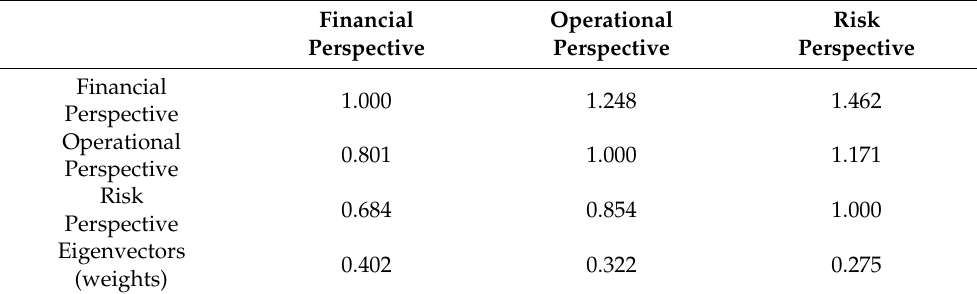
Table 2. The comparisons and eigenvectors (weights) of 3 perspectives.